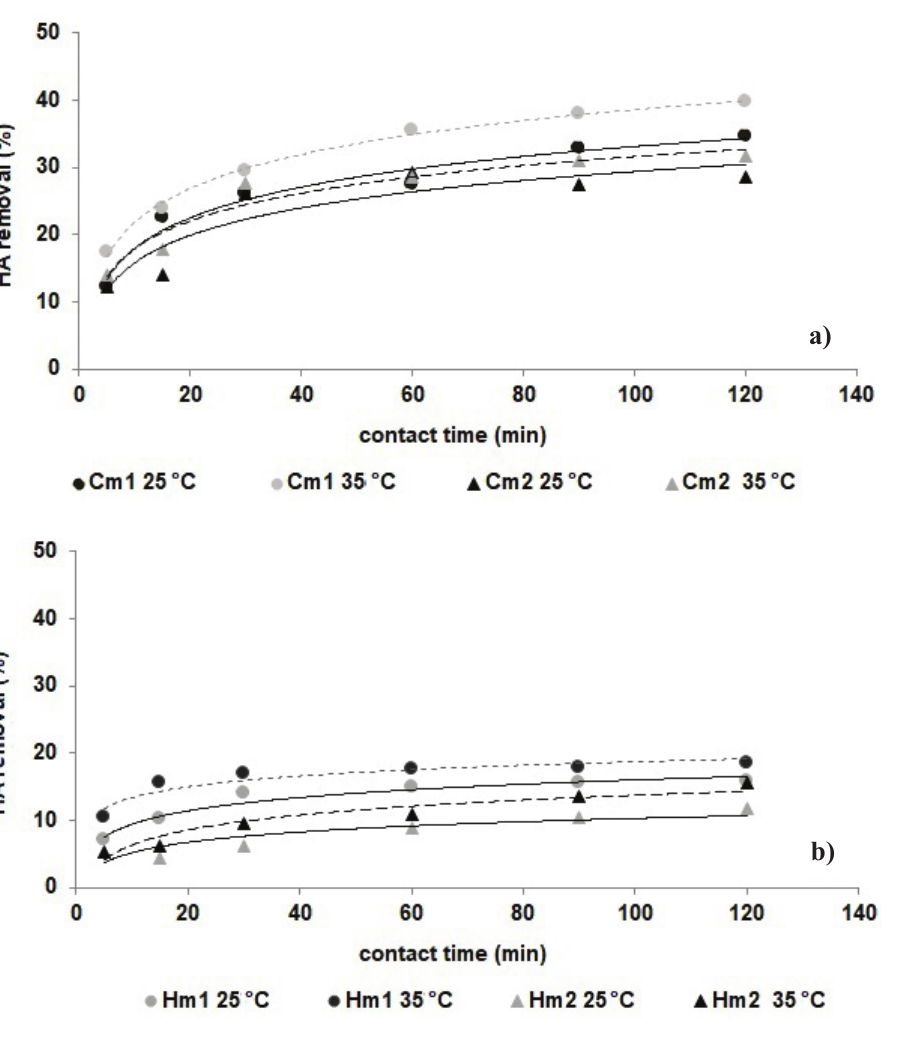
= 100 mL, pH = 7.5, 120 solution